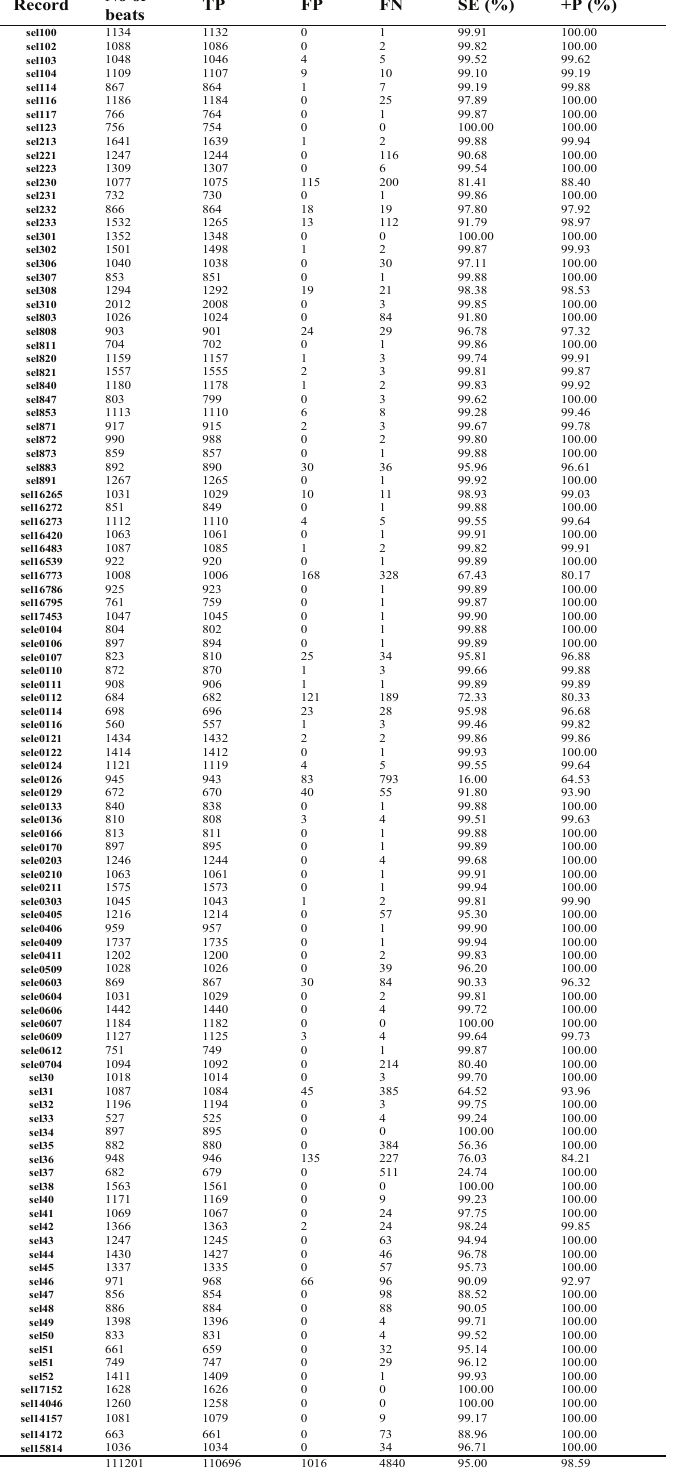
Table 3. T wave peak detection performance over the automatically annotated QT database [24]. To evaluate the performance of the T wave detection algorithm, two statistical measures are used: SE = TP / (TP + FN) and +P = TP / (TP + FP) , where TP is the number of true positives (T wave peak detected within the range of 30 ms of the annotated T wave peak), FN is the number of false negatives (annotated T wave peak has not been detected), and FP is the number of false positives (T wave peak detected outside the range of 30 ms of the annotated T wave